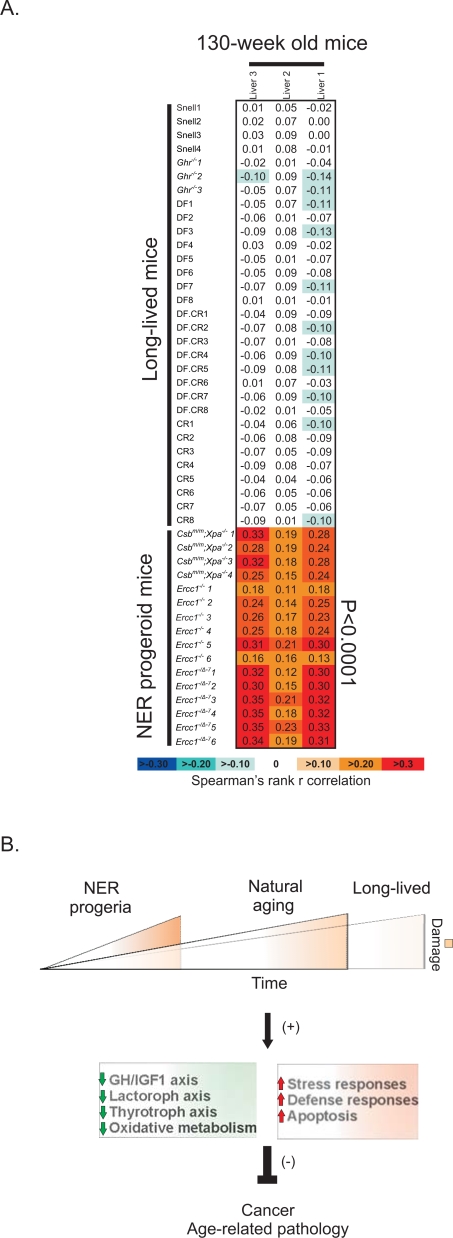
Genome-wide expression correlations between progeroid, long-lived and naturally aged mice.(A) Correlation between the transcriptomes of individual NER progeroid or long-lived mouse livers as compared to their respective wt controls and naturally aged mouse livers. The analysis was performed by pooling all progeroid (Csbm/m;Xpa−/−, Ercc1−/− and Ercc1−/Δ−7) and long lived mice (Ghr
−/−, Ames, CR, Ames-CR and Snell) into two separate groups and derive the genes whose expression changed significantly as compared to the group of all their respective controls (i.e. all the wt mice of either the progeroid or long-lived mice; Figure S1A, two-sided t-test, p<0.01). Using the non-parametric Spearman's rank correlation coefficient, we then asked whether the “progeroid” or “long-lived” genes have the same or opposite direction of expression change with those seen in the livers of 130-week old as compared to 13-week old mice. Note the significant positive correlation (red) between NER progeroid but not long-lived and naturally aged mouse liver expression profiles. (B) A model for the pro-survival/life extension response that occurs with aging: DNA damage accumulates with age or rapidly in organisms with defects in DNA repair. This triggers a systemic response that includes the suppression of the GH/IGF1 axis and oxidative metabolism and up-regulation of stress responses. Similar transcriptional changes are seen in long-lived organisms (dwarf mutants or as a consequence of CR) and with aging. This response shifts resources from growth to somatic maintenance, thereby protecting against cancer and delaying the onset of age-related pathology.